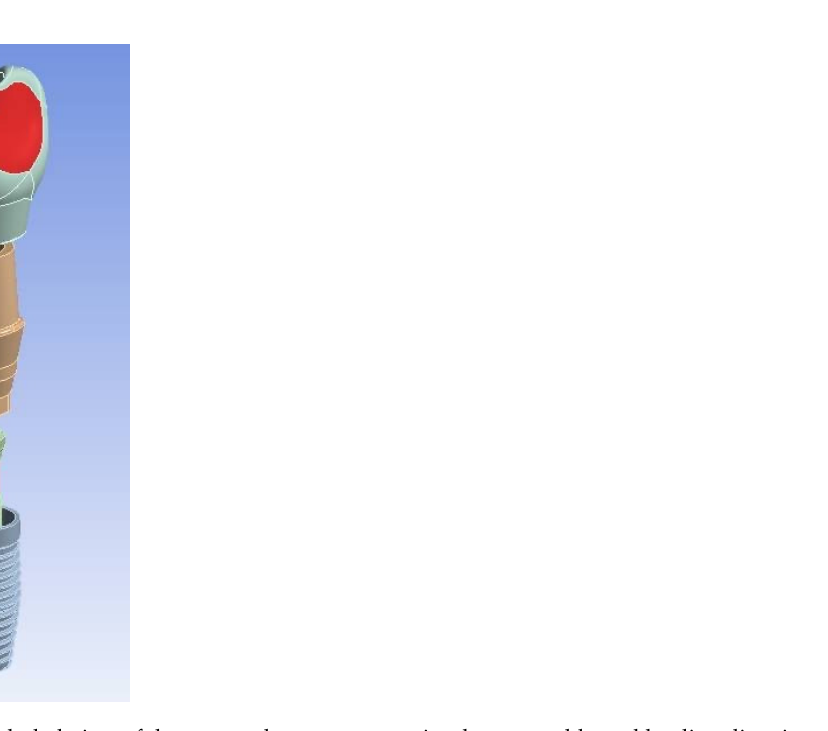
Figure 4. The exploded view of the crown-abutment-screw–implant assembly and loading direction: ( A ) lateral force of 170 N applied to the palatal surface of the crown and ( B ) axial force of 511 N applied to the screw.